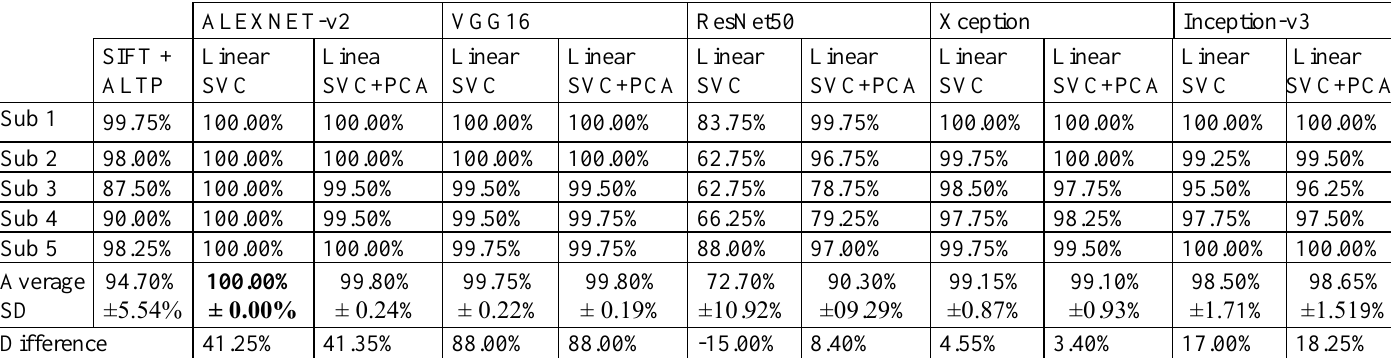
Table 8. Recognition accuracy ratio of SIFT +ALTP method and different deep learning models with data augmentation on the FERET database, and the difference of accuracies with various deep learning models with